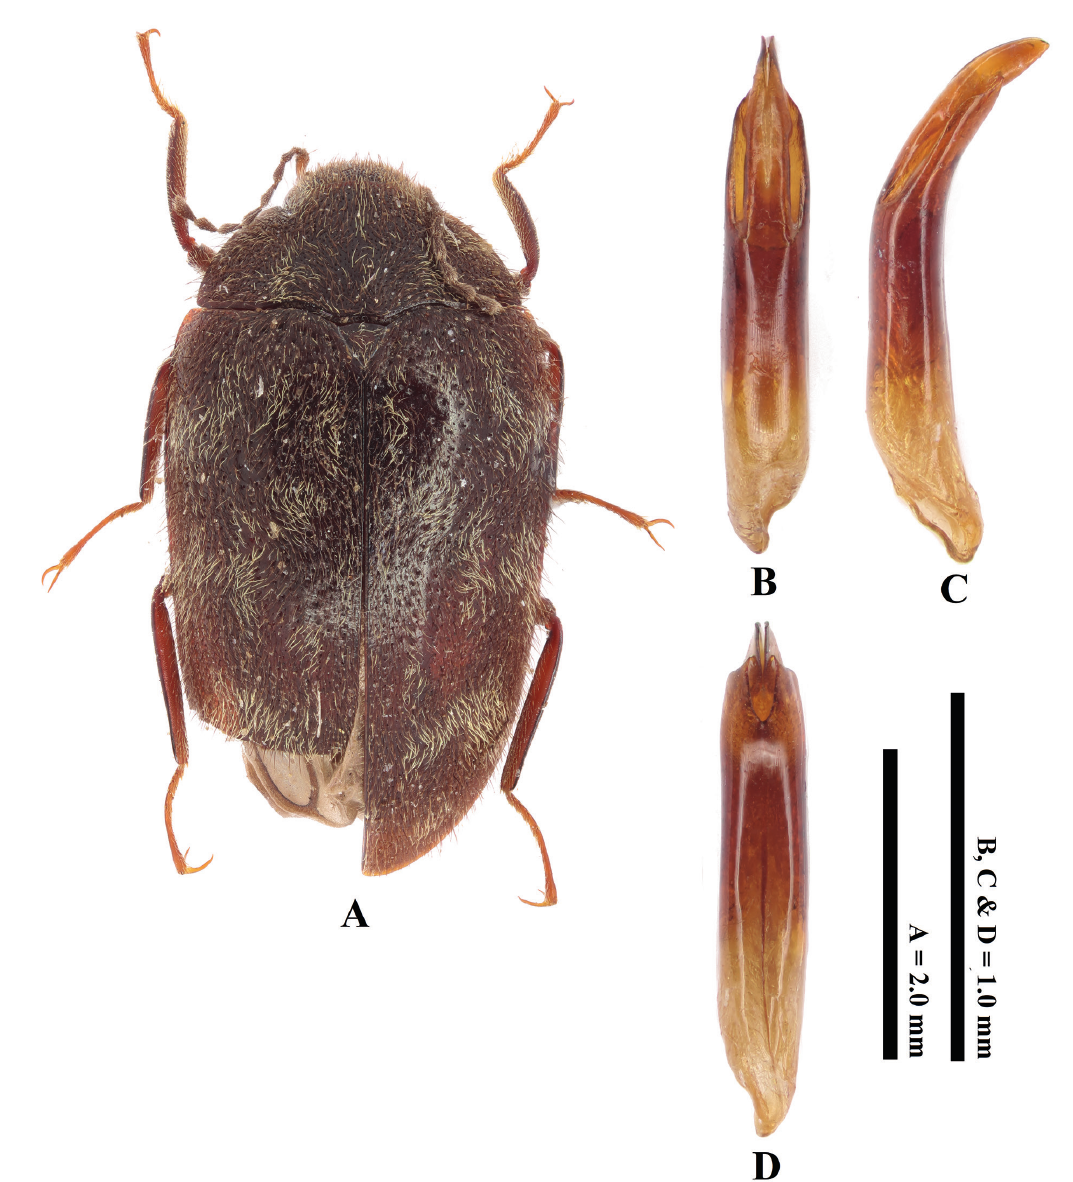
Fig. 5. Caccothryptus tardarsauceae sp. nov., ♂, holotype (NHMUK011225274). A . Dorsal